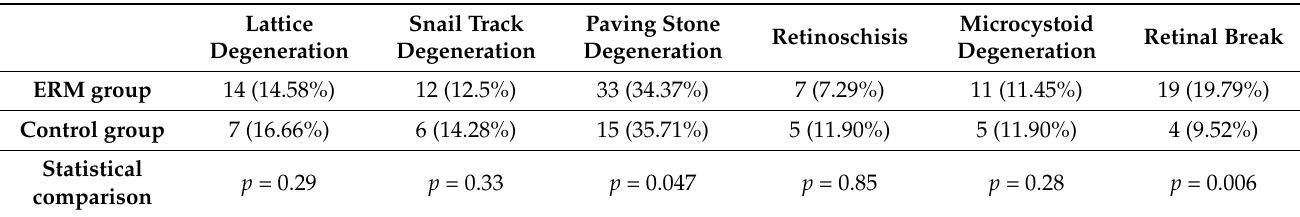
Table 1. Peripheral retinal changes in patients without (control) and with epiretinal membrane (ERM) detected using Goldmann three-mirror contact lens